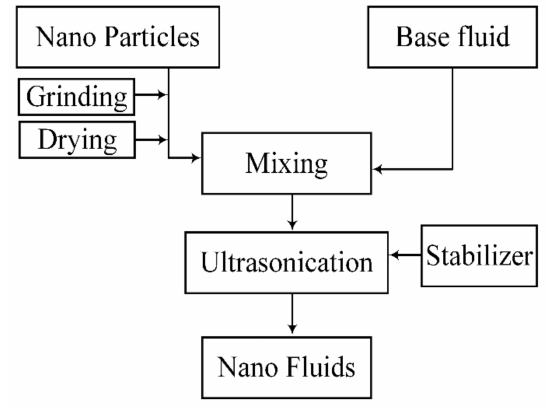
Figure 1. Steps involved in the nanofluid formulation